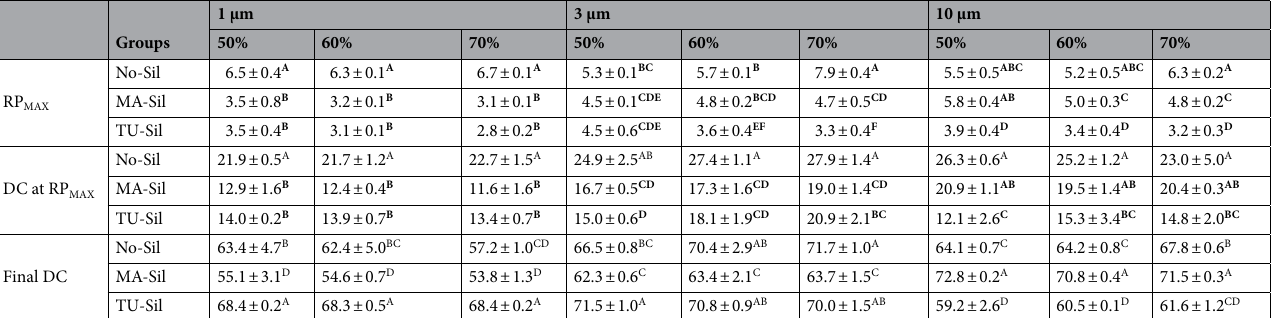
Table 2. Average ± SD of maximum rate of polymerization (RP MAX , %.s −1 ), degree of conversion at